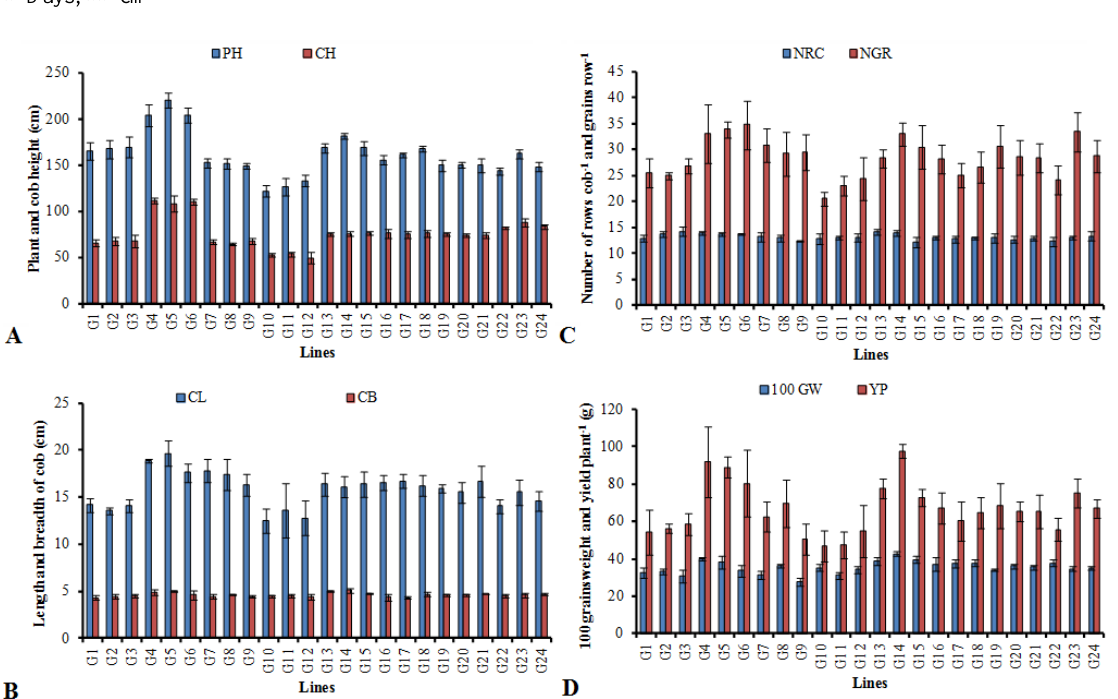
Fig. 1. Mean performance over three replications of white maize: A) plant and cob height (cm); B) the number of rows cob -1 and grains row -1 ; C) length and breadth of cob (cm); D) 100 grains weight and yield plant -1 (g) of twenty-four F 3 populations of white